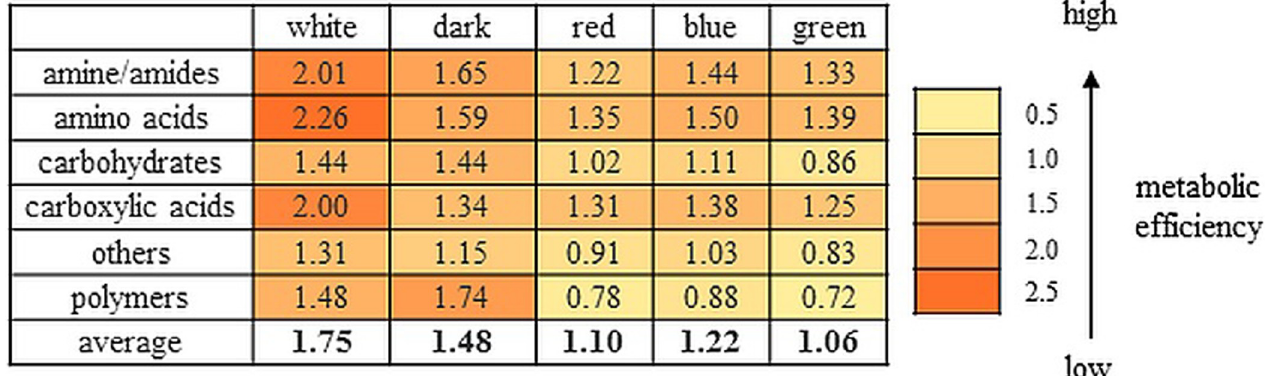
Fig 5. Ratio between normalized values of substrate use (OD 490nm) and biomass production (OD 750nm) defining theoretical metabolic efficiency of C . unicolor cultured in different lightning treatment (white, red, blue and, green light, darkness).